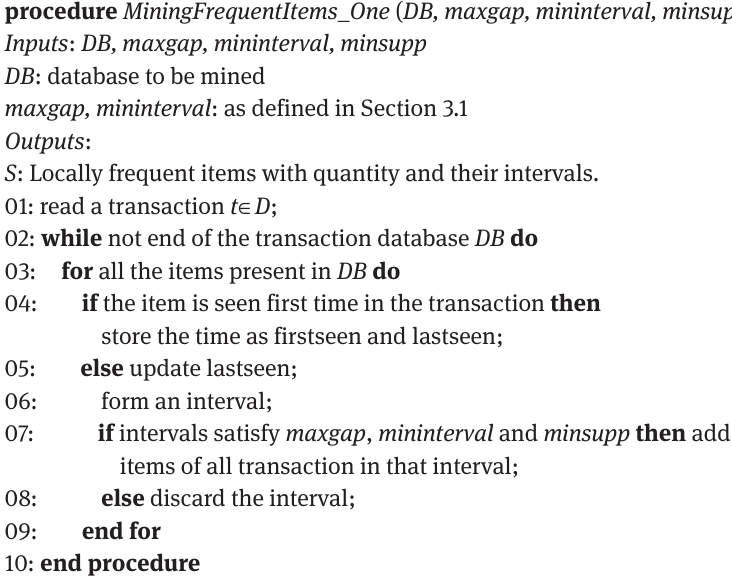
Algorithm 1. Mine locally frequent items with quantity and their intervals